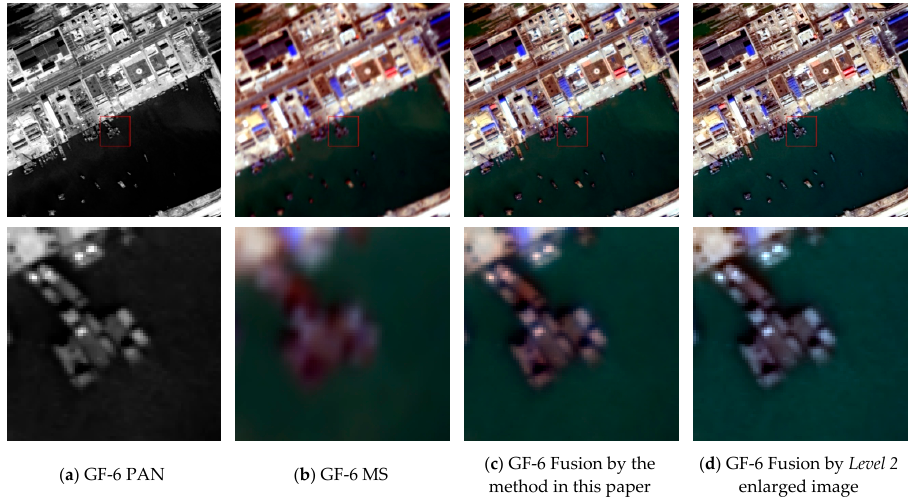
Figure 6. Comparison of the GF-6 fusion image created using the method in this paper and the fusion image created using the Level 2 PAN image and the MS enlarged image. ( a ) PAN image; ( b ) enlarged MS image; ( c ) fusion image created using the method in this paper; ( d ) fusion image created using the enlarged Level 2 image.